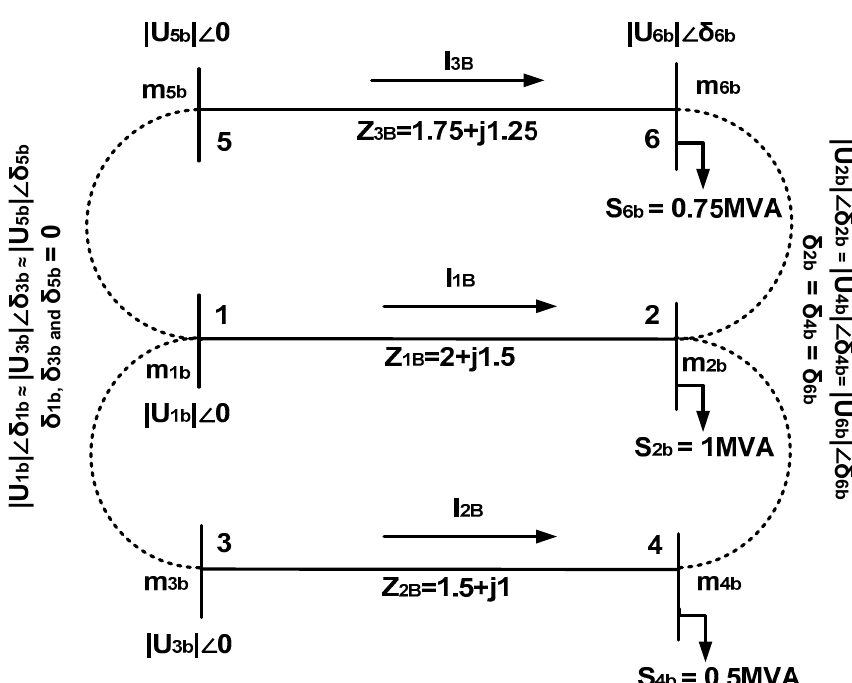
Figure A1. A simple test distribution system for illustration of computation procedure.